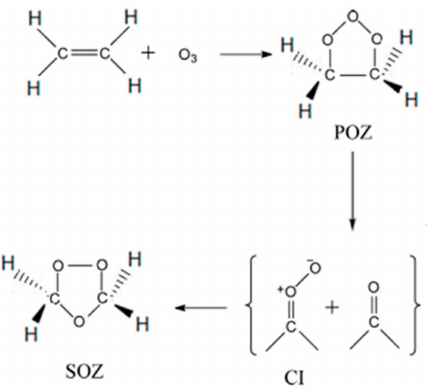
Figure 1. The formation of secondary ozonide (SOZ) in the ozonolysis of